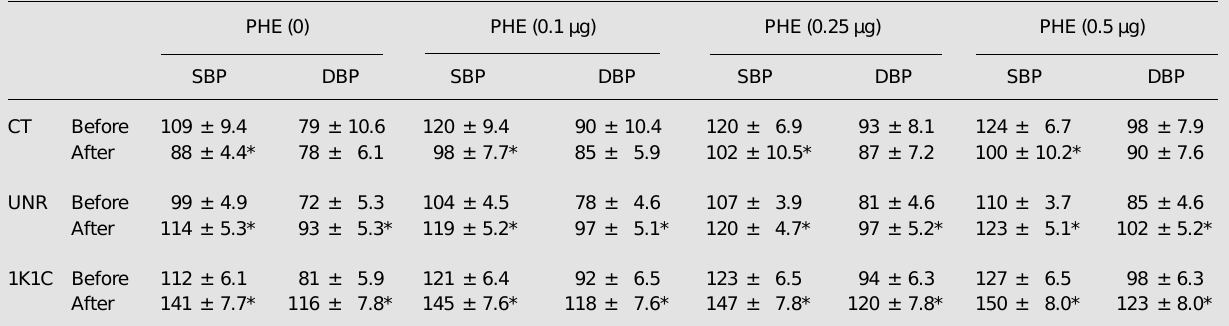
Table 3. Changes in systolic (SBP) and diastolic (DBP) arterial blood pressure (in mmHg) in response to the vasopressor effects of increasing doses of phenylephrine (PHE) before and after 1.8 mg/kg ouabain treatment in normotensive (control, CT; uninephrectomized, UNR) and hypertensive (1K1C) rats.